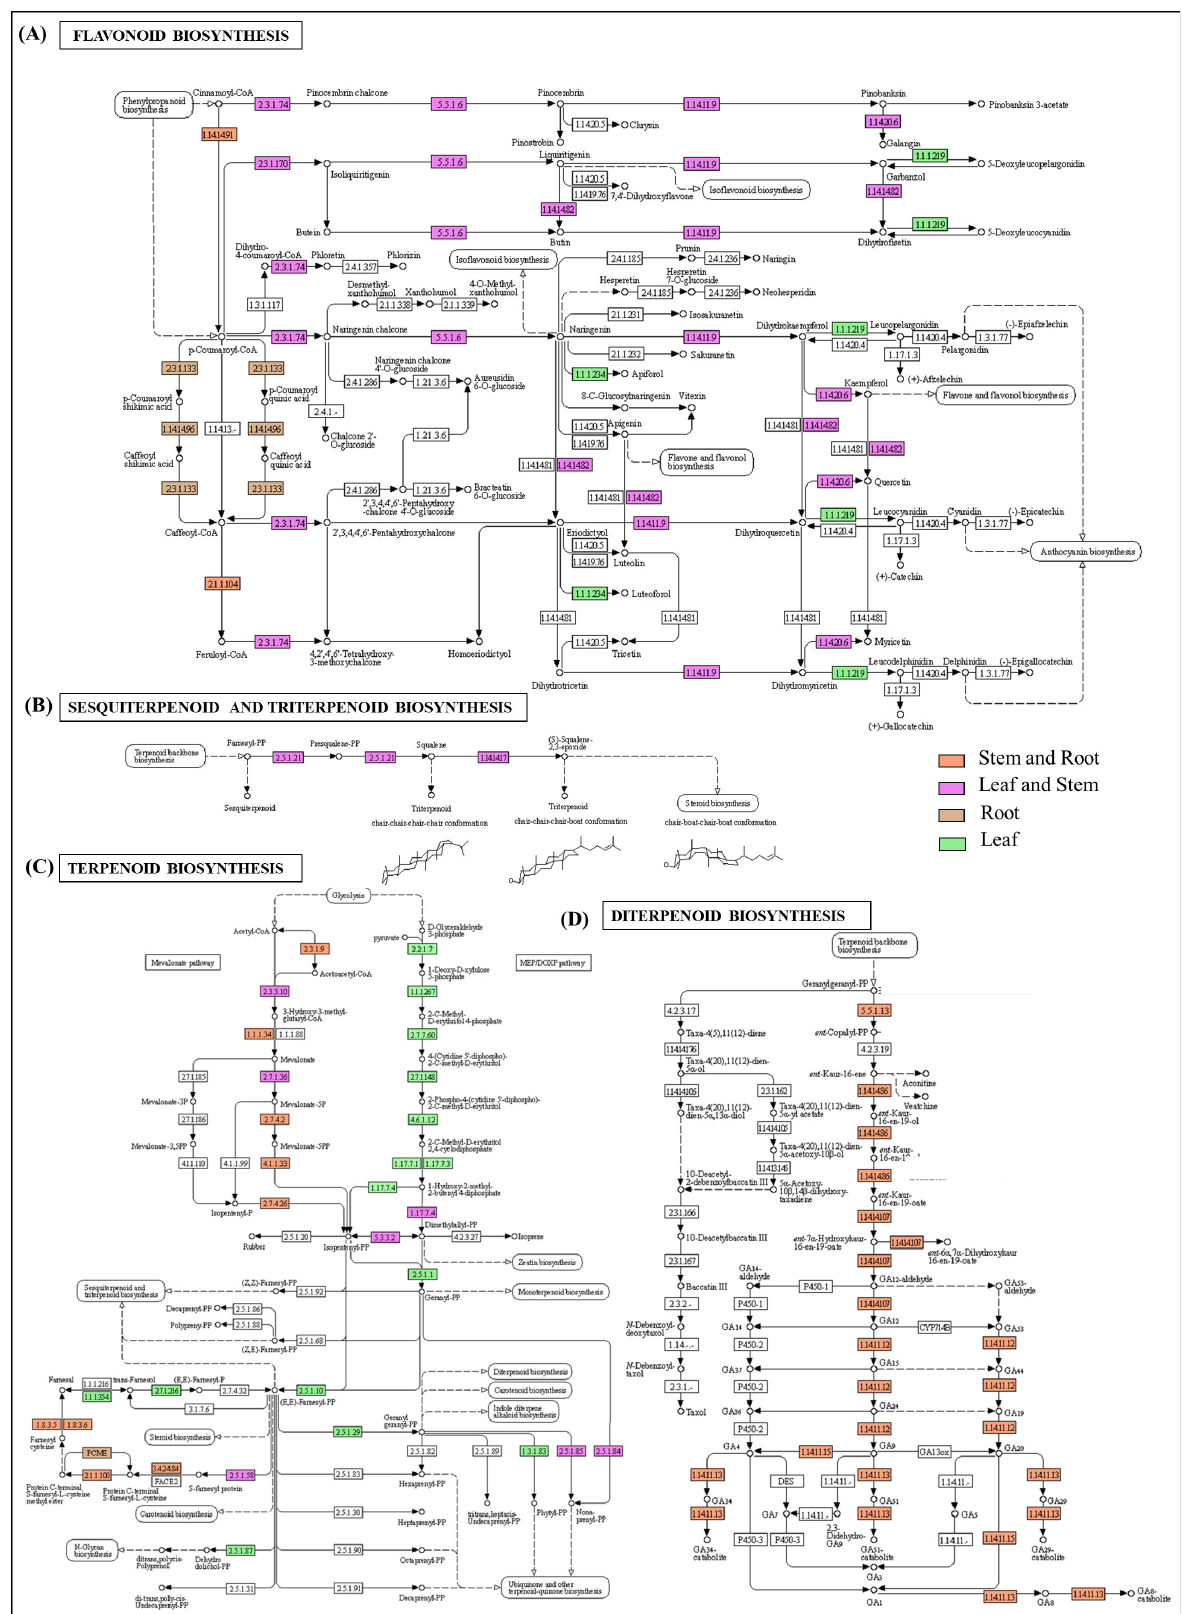
Figure 6. Representation of significant ( A ) flavonoids, ( B ) sesquiterpenoid and triterpenoid biosyn- thesis; ( C ) terpene backbone; ( D ) diterpenoids, in leaf, stem, and root tissues of A. glauca